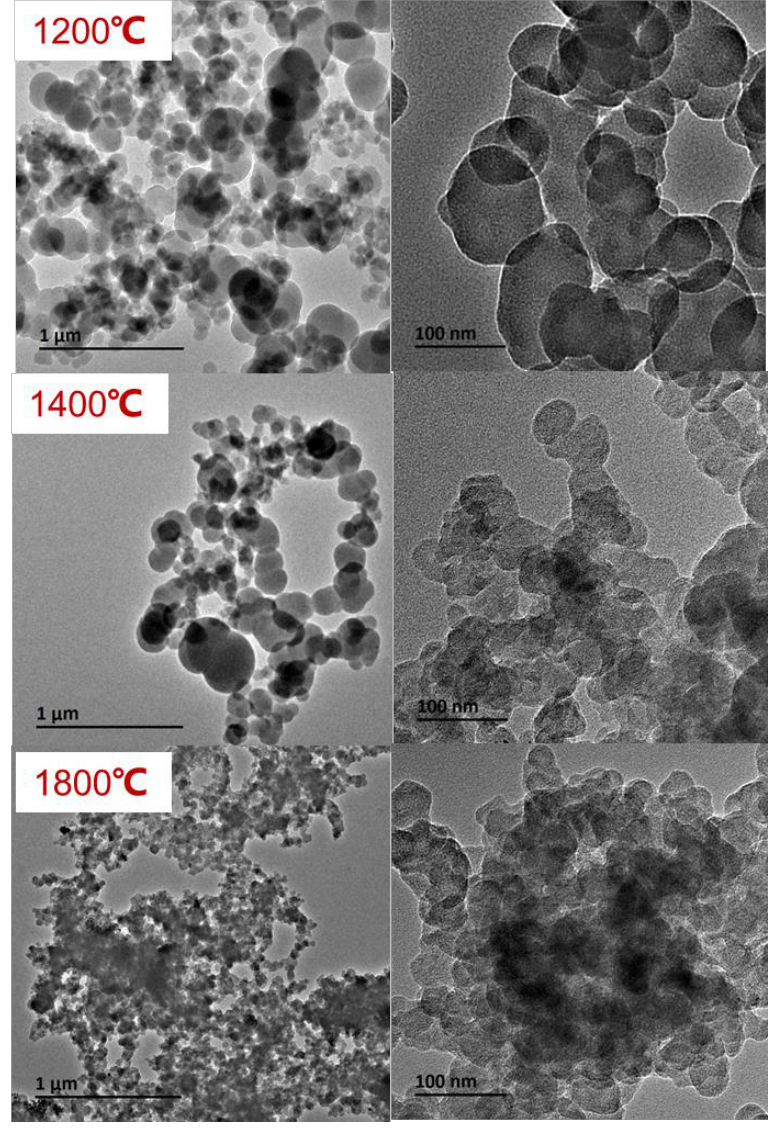
Figure 7. TEM images of carbon